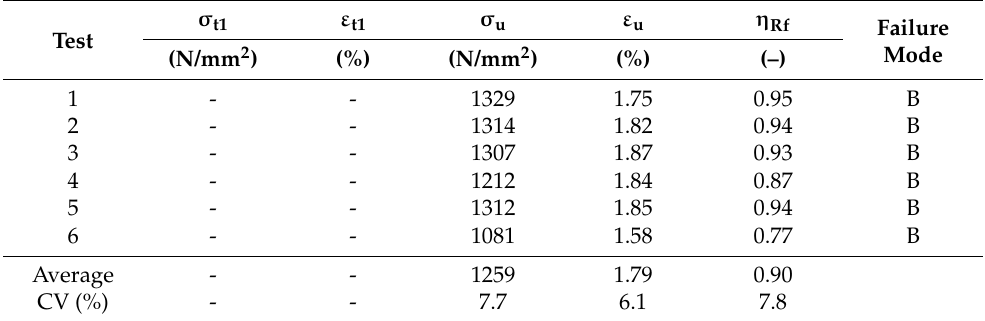
Figure 9. A-G test results: ( a ) stress–strain curves; ( b ) typical crack pattern; ( c ) specimens after the test. Table 9. A-G test results.